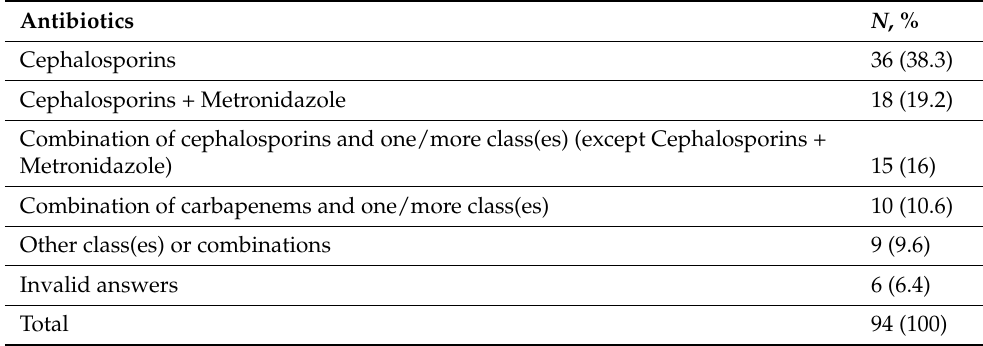
Table 6. Antibiotics used in appendiceal mass.